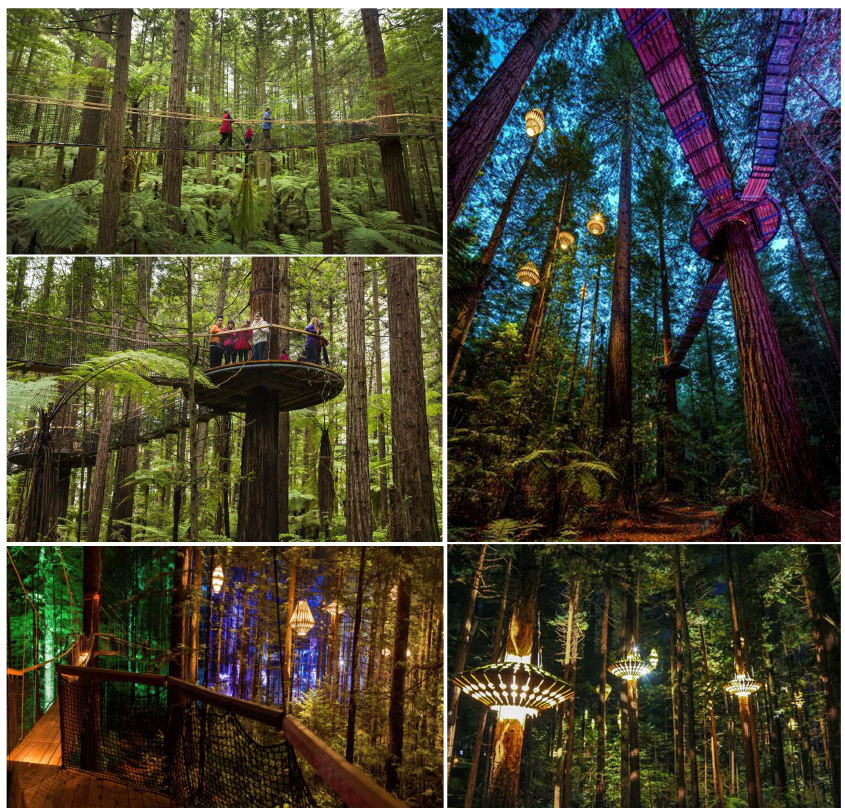
Figure A5. The pictures of “City Viewing Plank Road” of Jinji Mountainous Park in Fuzhou.